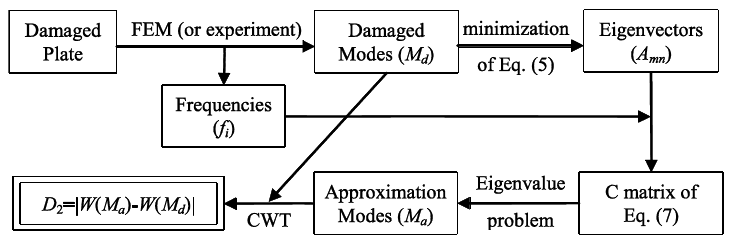
Fig. 5. Diagram for damage detection based on Ritz method and wavelet